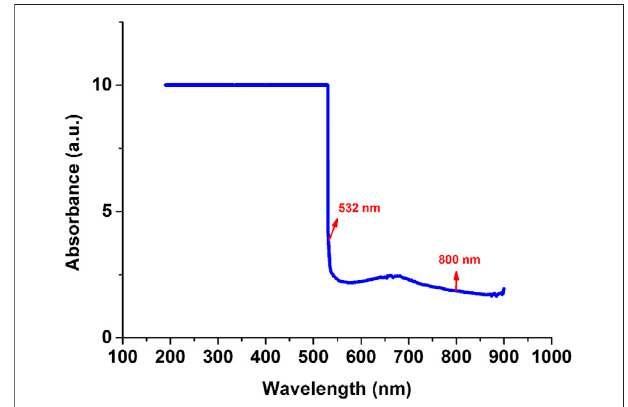
FIGURE 1 | Ground state absorption of the obtained nitrogen-doped diamond